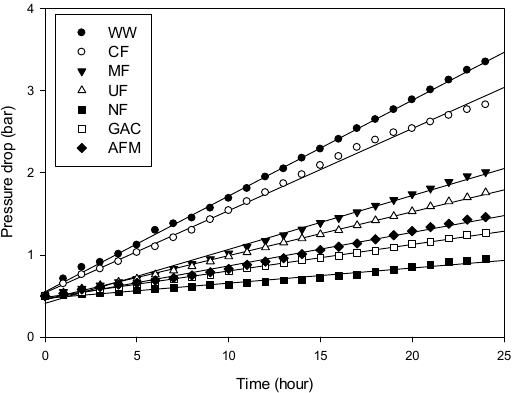
Figure 7. Changes in stack pressure with time for feed solutions with different pretreatments.